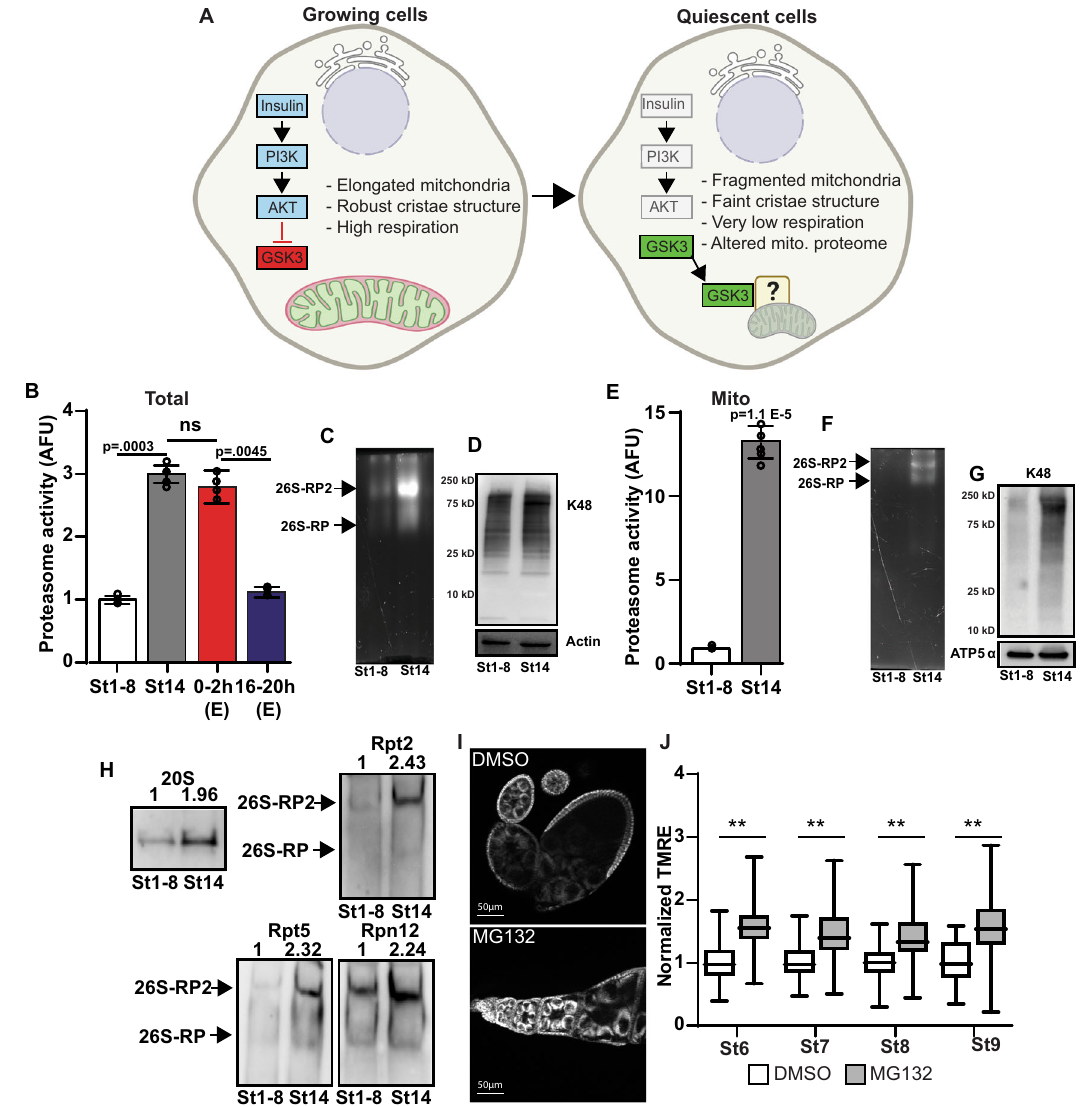
Fig. 1 | The proteasome is recruited to the mitochondria during cellular quiescence.A Model ofInsulin-AKT-GSK3 regulation of mitochondrial respiration quiescence (MRQ). Created with Biorender. B Proteasome activity from st1 – 8 oocytes(active), st14 oocytes(quiescent), and embryos (collected 0 – 2h and 16 – 20h posted egg laying) ( n =4 completely independent experiments on inde- pendentsamples). C In-gelhydrolysisassaytoexaminetotalproteasomeactivityin st1 – 8 and st14 eggs. This experiment was replicated 3 times with biological repli- cates. D Western blotting examines K48 ubiquitin levels in total cell lysis in st1 – 8 and st14 eggs. E Mitochondria-associated proteasome activity in st1 – 8 and st14 oocytes( n =6independentbiologicalreplicates). F In-gelhydrolysisassayexamine mitochondria-associated proteasome activity in st1 – 8 and st14 eggs. This experi- ment was replicated 3 times with biological replicates. G Western blotting to examineK48ubiquitinlevelsinmitochondrialfractionsinst1 – 8andst14eggs.This experiment was replicated 3 times with biological replicates. H Native Western